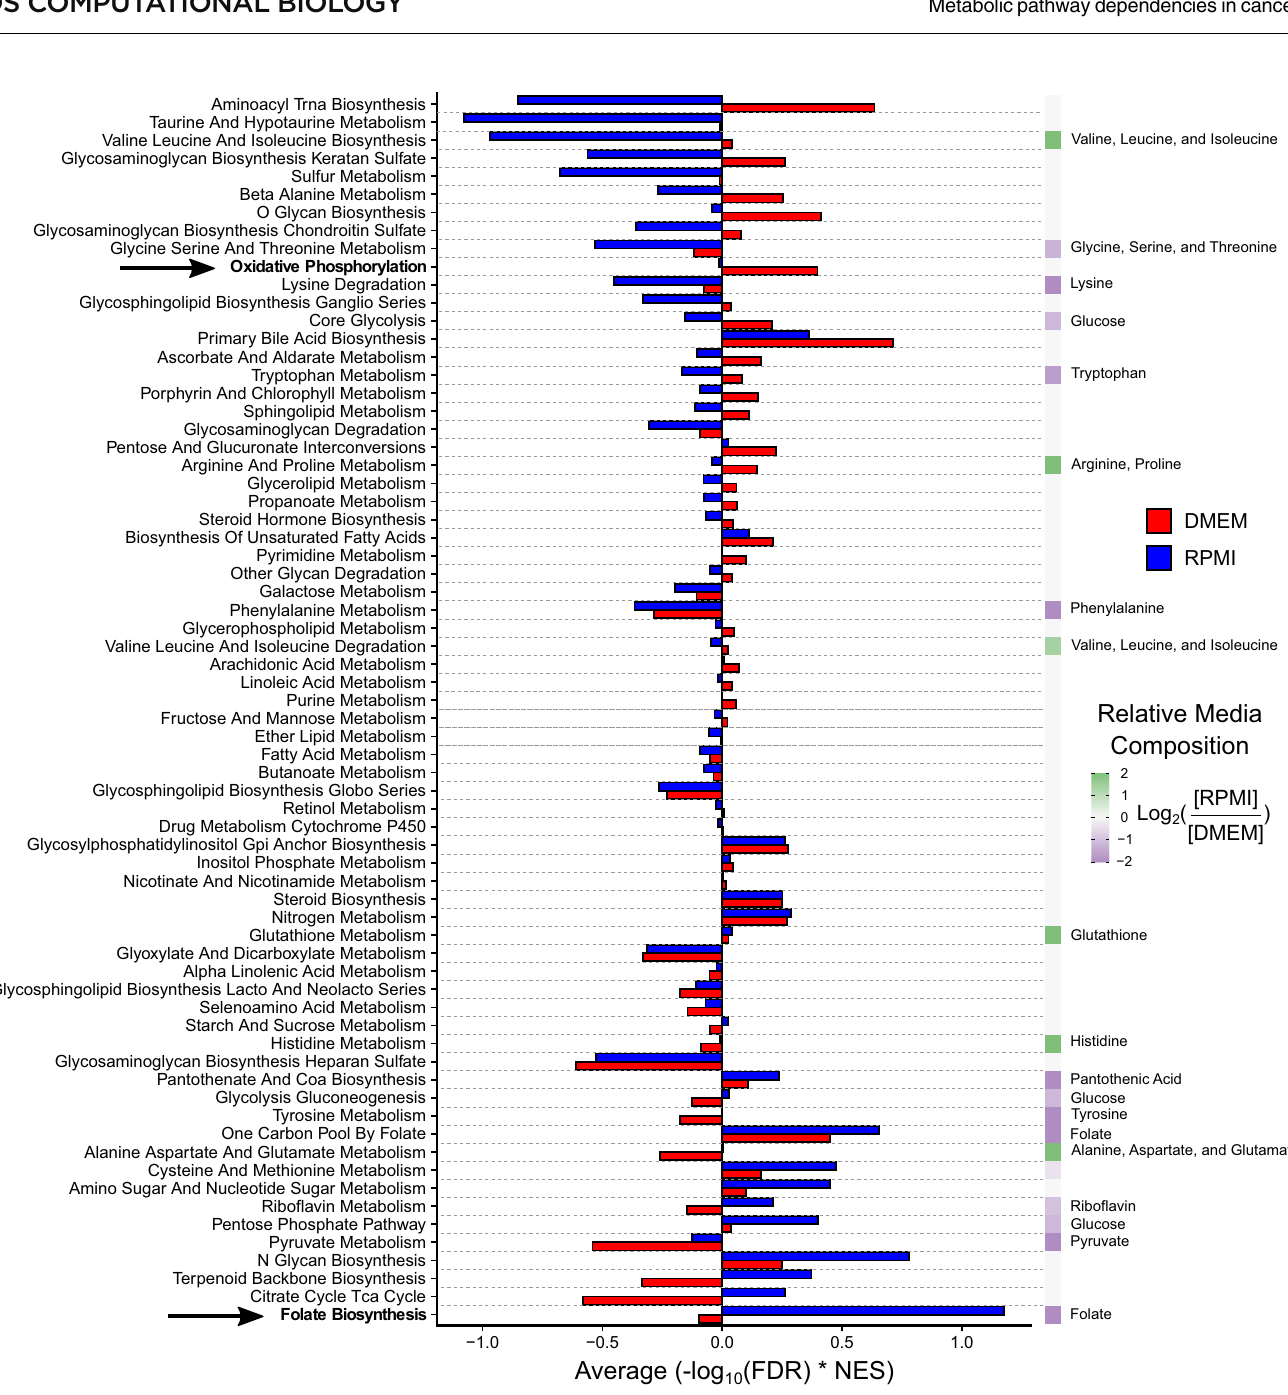
Fig 3. Media composition influences metabolic pathway dependency. For adherent cancer cell lines cultured in RPMI (Fig 2) and DMEM (S2 Fig), the metabolic pathway dependency NESs from Genetic PDEA analysis were weighted by -log 10 FDR. The weighted NESs were then averaged across all 69 KEGG metabolic pathways. Pathways are ranked by the difference between DMEM and RPMI. The relative media composition between RPMI and DMEM are shown on the right on a purple to green heat map with the relevant metabolite(s) indicated. For pathways with multiple metabolites, the average of the metabolites was taken. For example, the concentration of folate in RPMI and DMEM is 1 mg/L and 4 mg/L, respectively. Folate is shown twice because it is both the product of Folate Biosynthesis and the input to One-Carbon Pool by Folate. The dependency on Folate Biosynthesis was much higher in RPMI than in DMEM because these cells must synthesize more folate. Conversely, the dependency on oxidative phosphorylation is much higher in DMEM. This may be due to differences in aspartate levels (RPMI 150 μ M, DMEM 0 μ M). The indicated pathways are highlighted in bold. Overall, pathways that contained a metabolite which is differentially abundant in cell culture media exhibited a significant difference in pathway essentiality in DMEM and RPMI (p = 3.9x10 -4 by paired Mann-Whitney U test). In contrast, pathways that do not contain differentially abundant cell culture media metabolites did not exhibit significantly different pathway dependencies (p = 0.545 by paired Mann-Whitney U